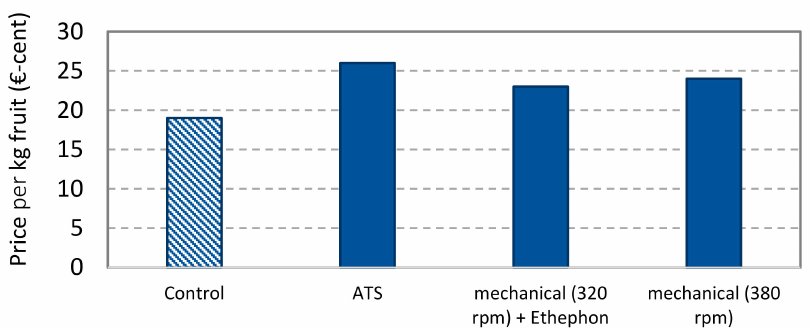
Figure 6. Financial returns from the thinning treatments, expressed as average prices in Euro cent per kg of fruit and based on the relative proportions of fruit sizes shown in Figure 5, and the following wholesale prices: < 30 mm = 4 cents / kg; 30–32 mm = 30 cents / kg; 32–35 mm = 40 cents / kg; > 35 mm = 60 cents / kg.